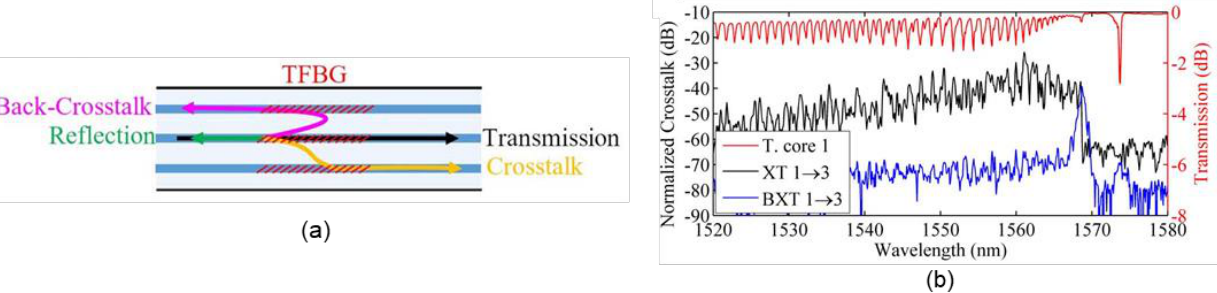
Figure 21. ( a ) Schematic diagram of the MCF with TFBG inscribed, showing inter-core crosstalk induced by TFBG; ( b ) transmission spectra of inscribed TFBG, crosstalk, and back crosstalk between cores 1 and 3. Adapted with permission from Ref. [104] © 2017 Optica Publishing Group.